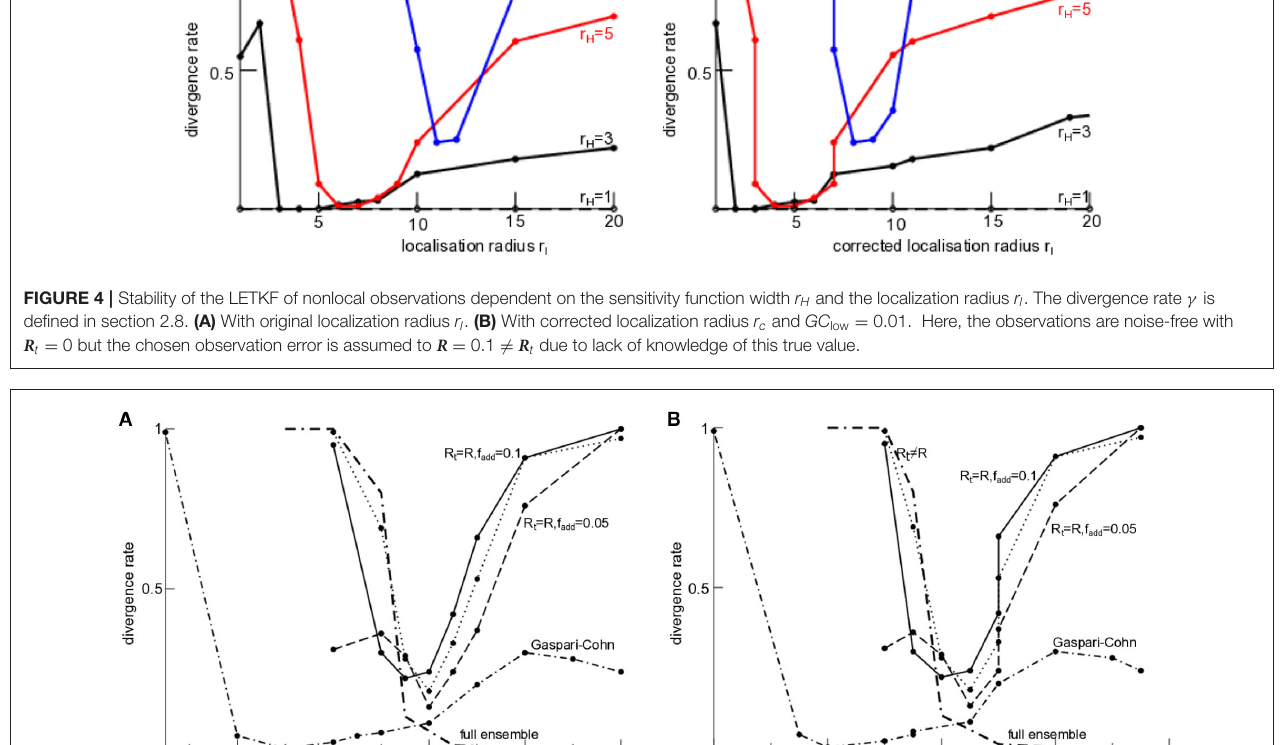
FIGURE 5 | LETKF stability for different parameters and r H 10. The solid line denotes the divergence rate γ if the true observation error R t = 0.1; the dashed line denotes the divergence rate for lower inflation rate f add R R t , and the inflation rate is f add = = dotted-dashed line marks results identical to the dashed line case but with a smooth Gaspari-Cohn sensitivity function. The dotted line is taken from Figure 4 for comparison ( R t 0, R 0.1) and the bold dotted-dashed line represents the results with an ensemble L = = localization radius r l . (B) Corrected localization radius r c with GC low =